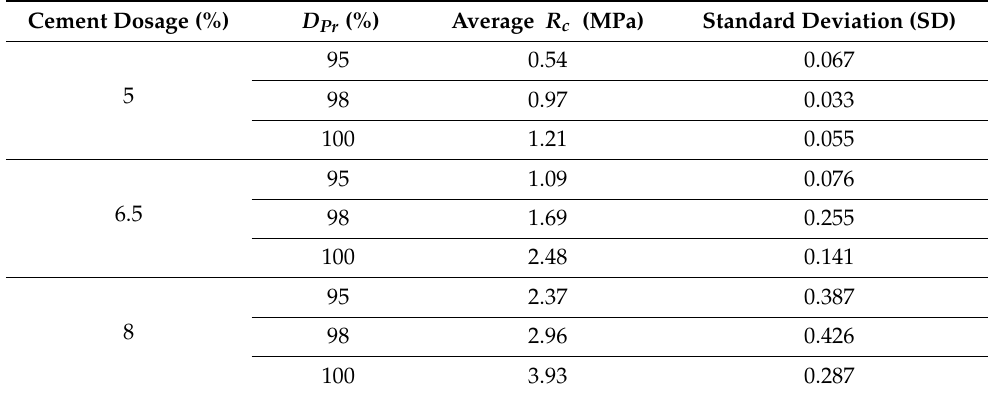
Table 3. Test results: unconfined compressive strength, R c , under different compaction ratios, D Pr , and various cement